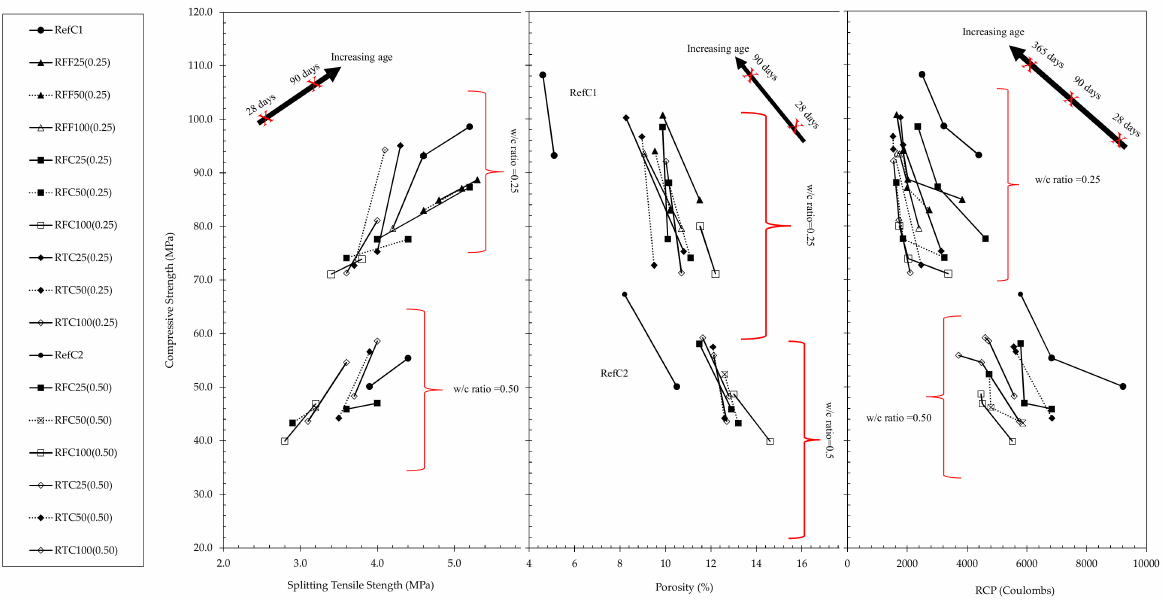
Figure 2. Relationship between compressive strength, porosity and chloride resistance of concrete mixtures.